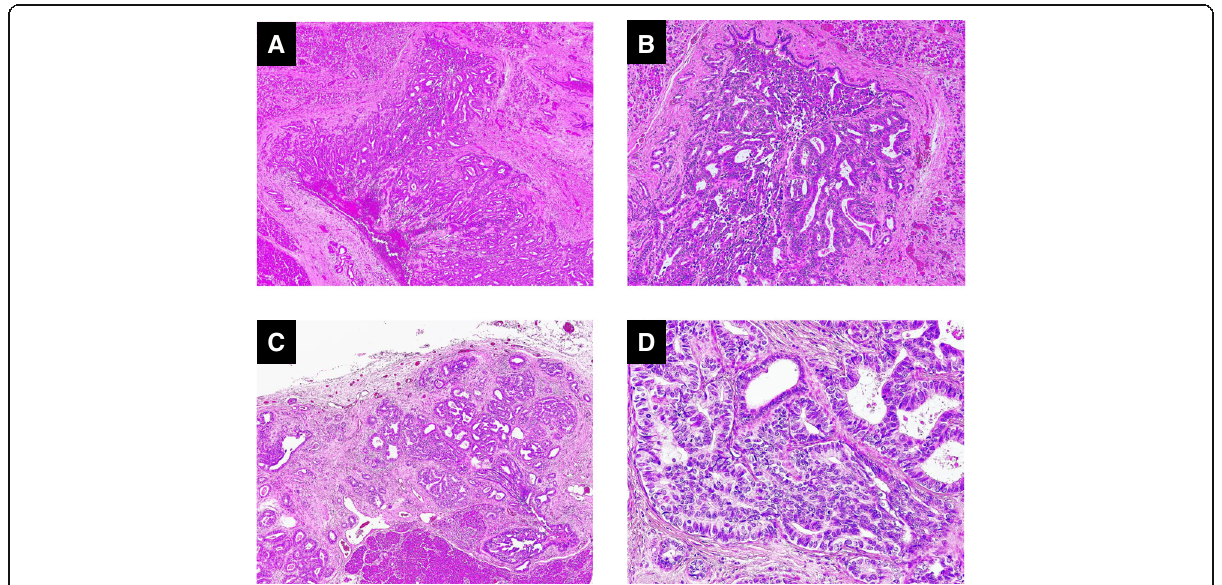
Fig. 5 Pathological findings of the secondary resected specimen of the pancreas body and tail lesions. a – d Microscopic findings of the resected specimen ( a , b pancreas body lesion; c , d pancreas tail lesion). a The tumor extended around and into the MPD (original magnification × 40). b The tumor showed a tubular growth pattern with scanty cytoplasmic mucin (original magnification × 100). c The tumor showed a tubular growth pattern (original magnification × 40). d The neoplastic cells showed a uniformly high-grade atypia, and apparent invasive carcinoma lesion was present (original magnification ×